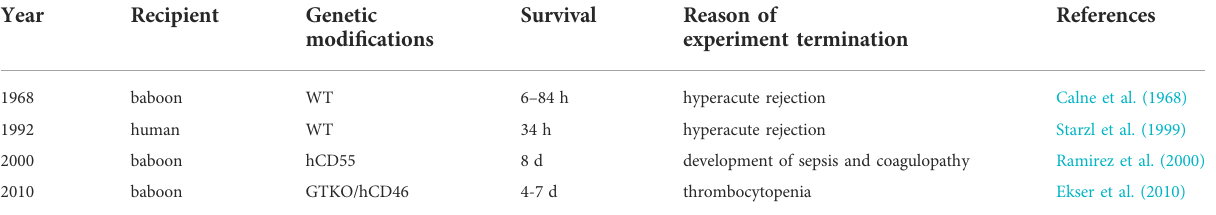
TABLE 3 Progress in transgenic porcine kidney